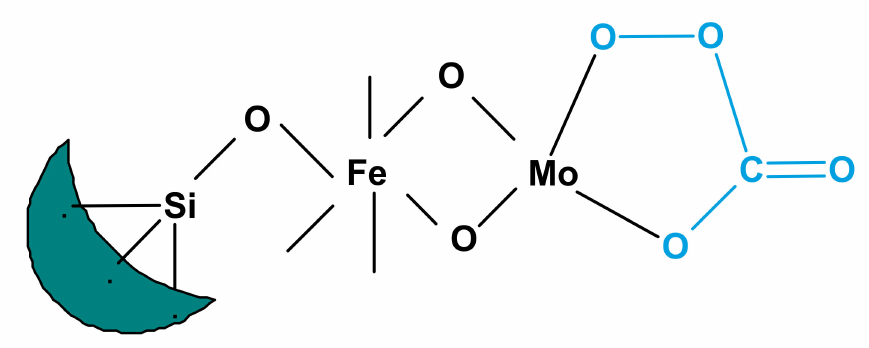
Figure 1. Per ox-carbonate over Fe / Mo / DBH in the O 2 / CO 2 system (Reproduced from [20]; copyright (1993), Elsevier (Amsterdam, The